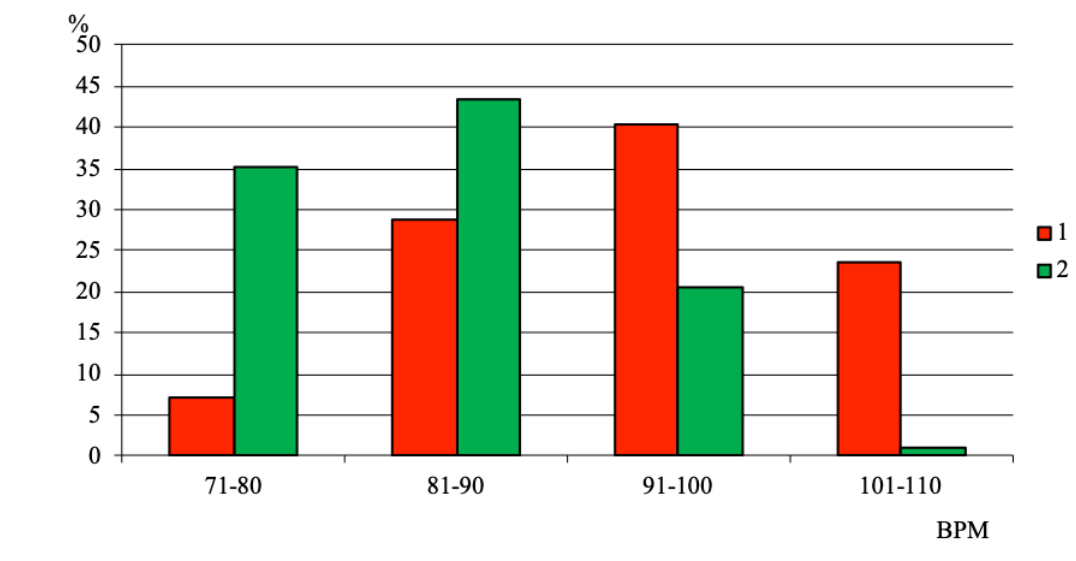
Figure 1. Combined heart rate of a fit student during the strength exercises (1 – in the isotonic mode, 2 – in the static mode)